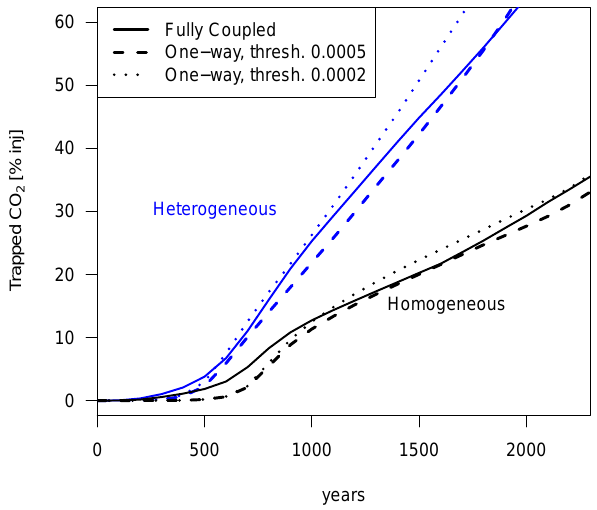
Figure 12. Influence of the threshold in case of slower kinetics, homogeneous